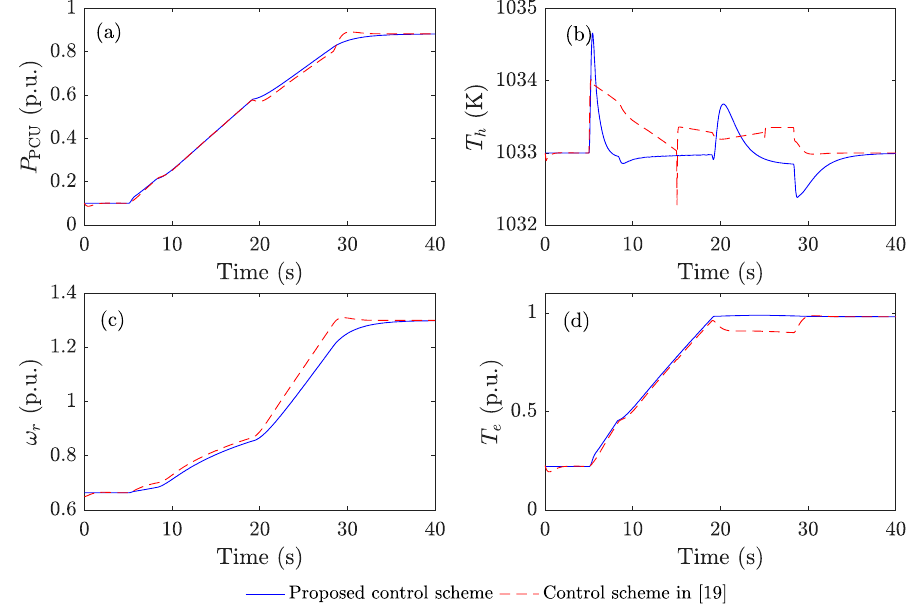
Figure 12. Comparison of different control schemes under a ramped increase of insolation: ( a ) power generated from PCU, ( b ) receiver temperature, ( c ) rotational speed of the DFIG, and ( d ) electromagnetic torque of the DFIG.